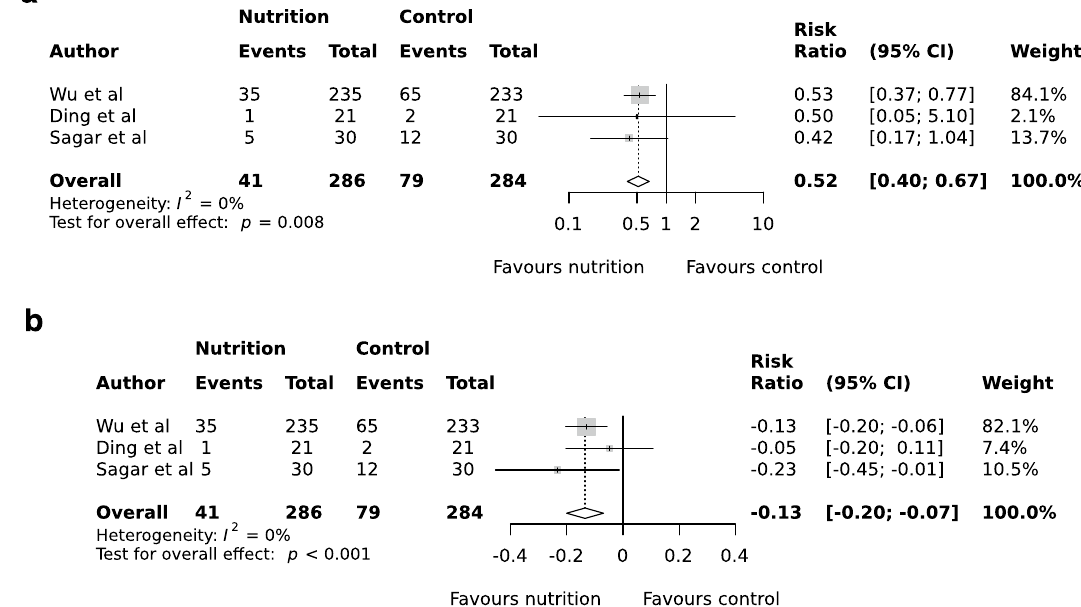
Figure 3. Random-effects meta-analysis of the effects of preoperative oral nutrition on infectious complications ( a ), and risk difference ( b ) in patients undergoing surgery for gastrointestinal